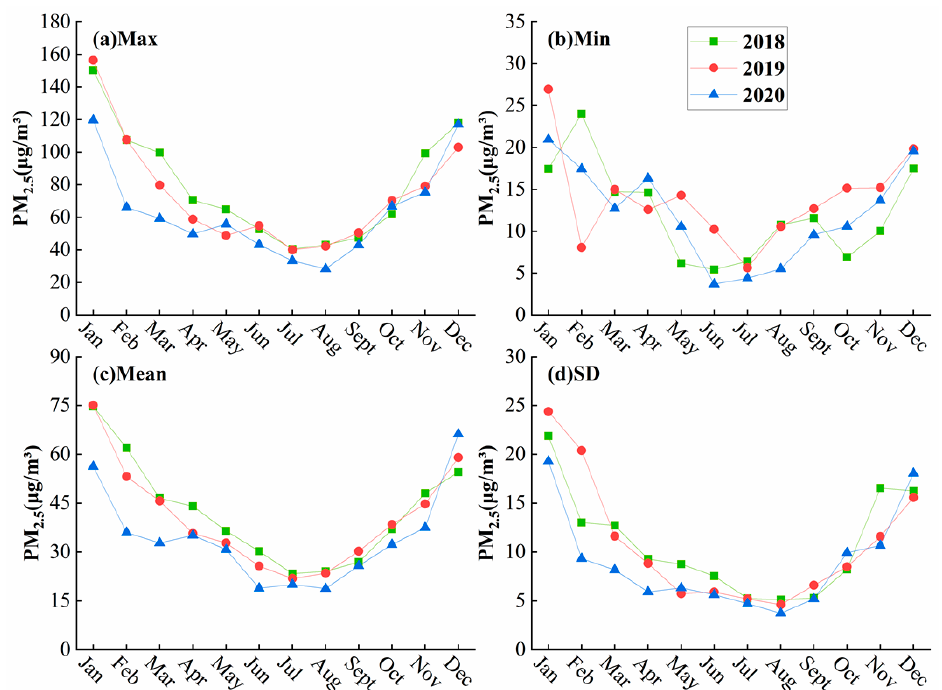
Figure 3. Descriptive statistical results of PM 2.5 . The graph includes the magnitude of the change in the ( a ) maximum (Max), ( b ) minimum (Min), ( c ) mean, and ( d ) standard deviation (SD) of PM 2.5 in